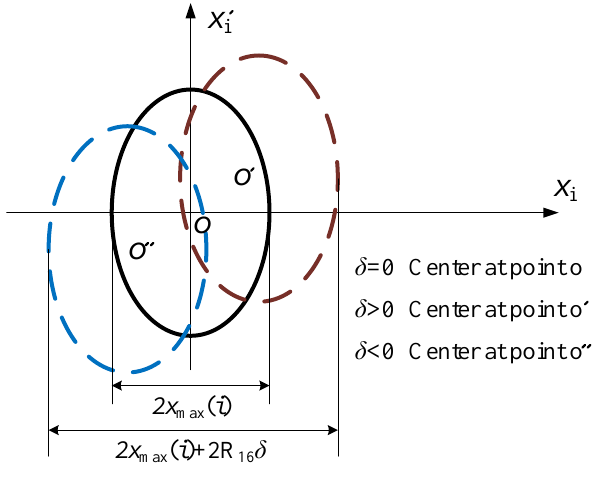
Figure 8. Momentum dispersion effect.